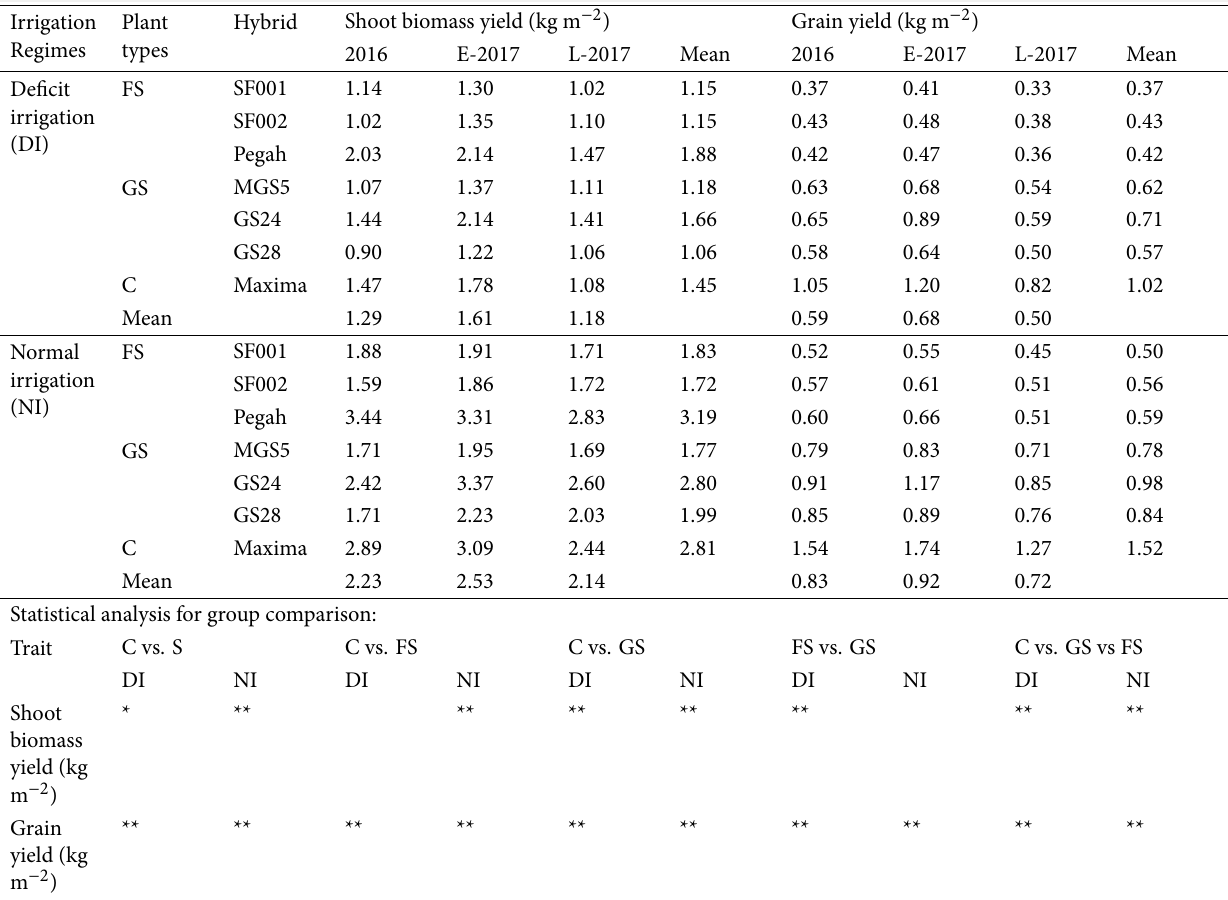
Table 3 Statistical analysis group comparisons (among the corn, grain sorghum, and forage sorghum genotypes studied) as well as comparisons of means for shoot biomass and grain yields (kg m